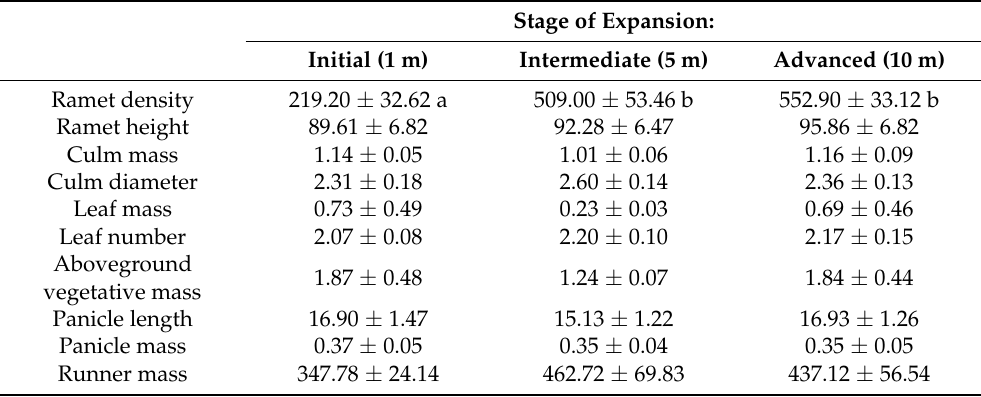
Table 1. Mean values of the biometric parameters of Calamagrostis epigejos ( ± SE) in successive stages of its expansion. Different letters in each column (a, b) show significant differences obtained after the Kruskal–Wallis test ( p ≤